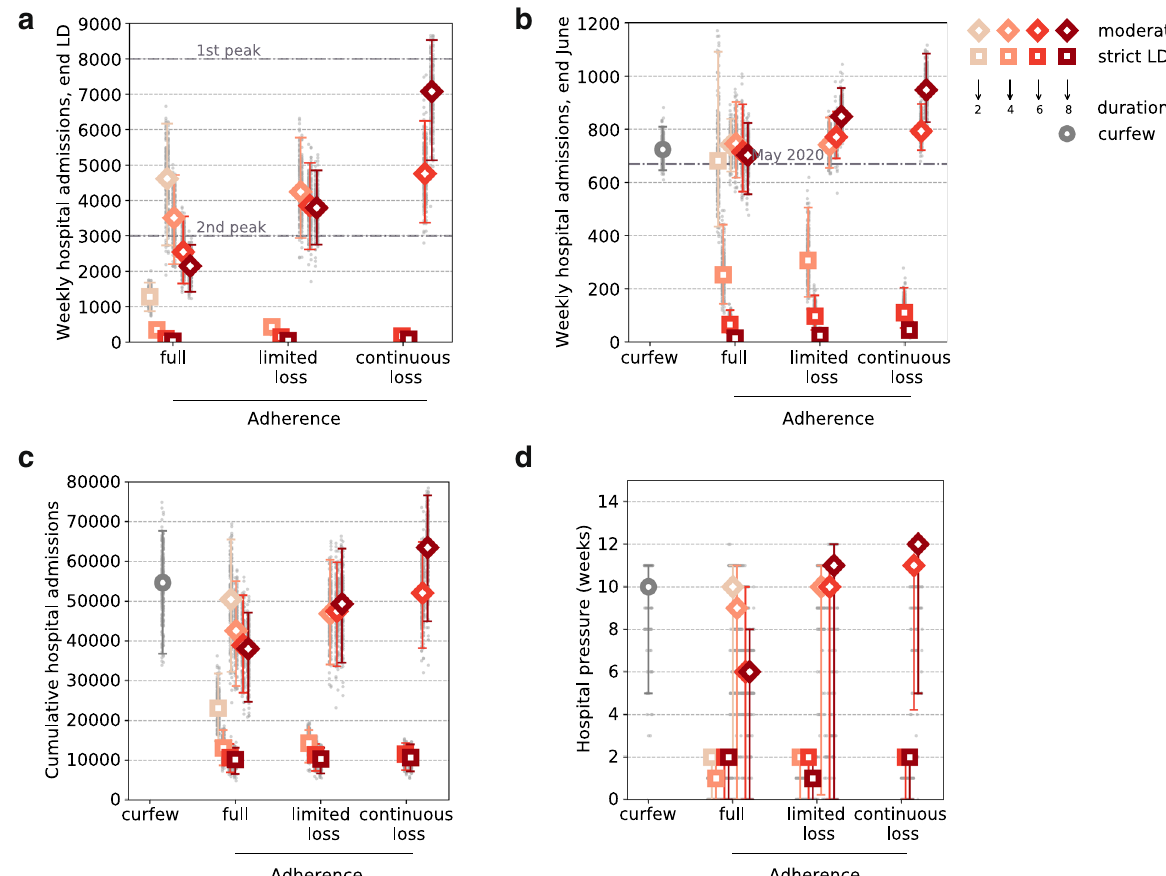
Fig. 3 Impact of loss of adherence on intervention ef fi cacy, for varying stringency and duration of interventions. Weekly hospital admissions at the end of the lockdown ( a ), weekly hospital admissions at the end of June (w26) ( b ), cumulative hospital admissions computed over the time period w12 – w26 ( c ), hospital pressure, de fi ned as the number of weeks in which hospital admissions remain above the peak level achieved during the second wave, in the period w12 – w26 ( d ) as functions of the adherence level — full adherence over time, limited loss of adherence, continuous loss of adherence over time. The